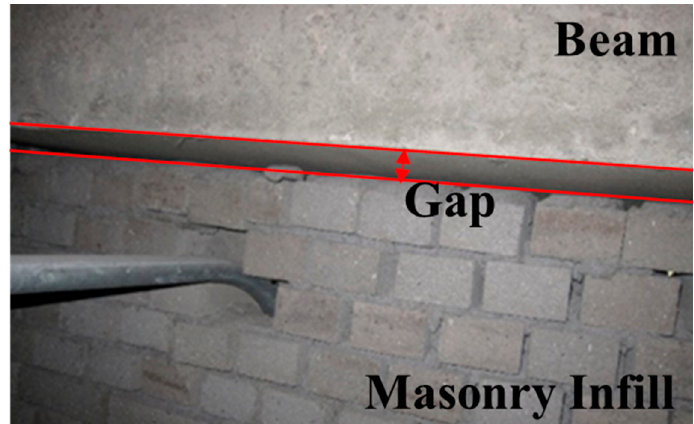
Figure 1. Gap between beam and masonry infill wall.